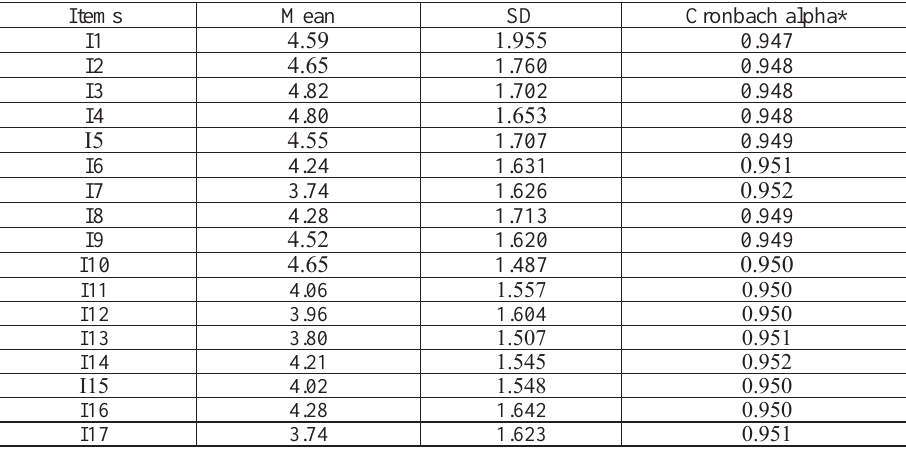
Table 1. Means, standard deviations, and Cronbach’s alphas for 17-item CETSCALE applied to North Cyprus